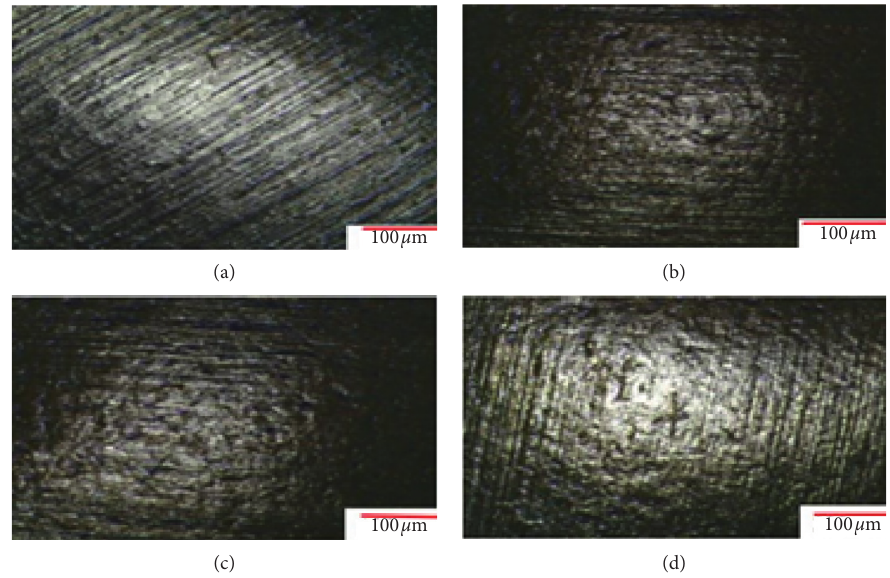
Figure 6: Surface morphology of the bottom region under different incident pressures: (a) 8MPa; (b) 12MPa; (c) 16MPa; (d) 20MPa.